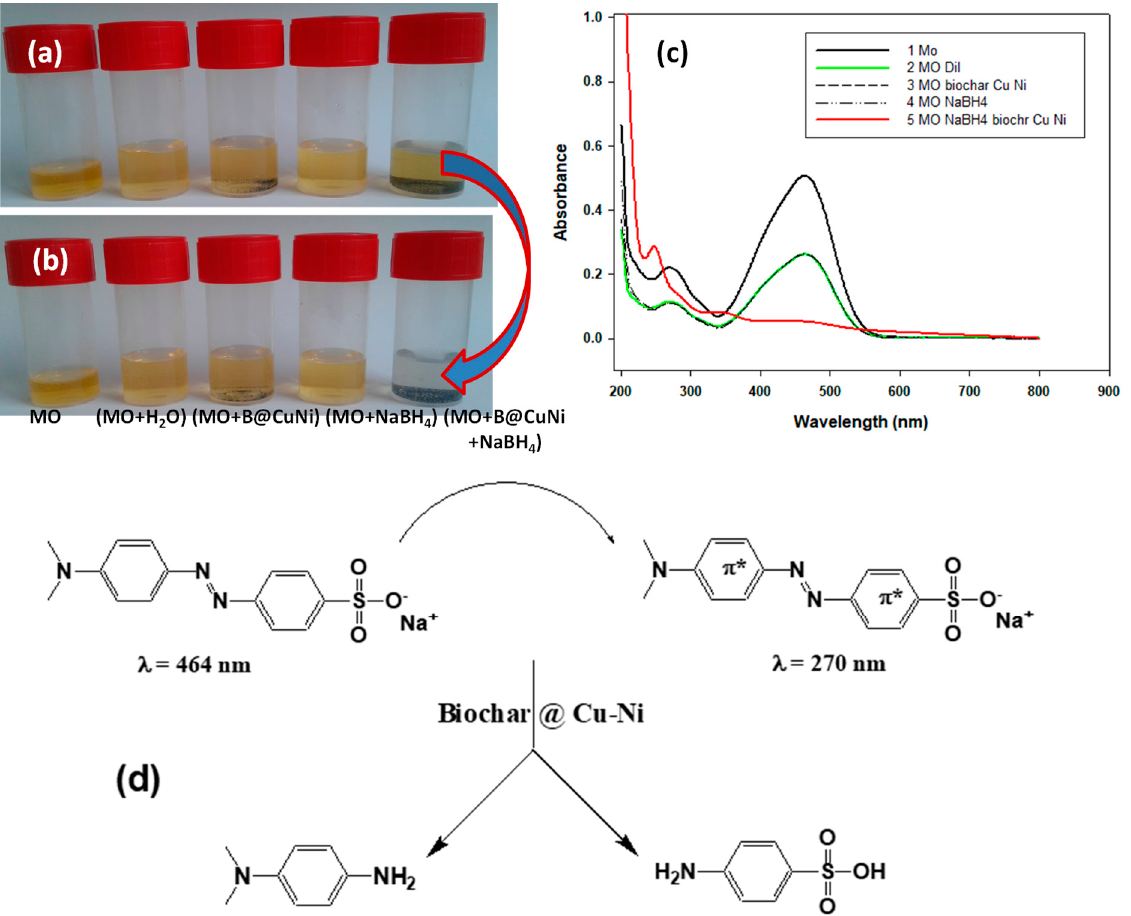
Figure 8. ( a , b ) Digital photographs and ( c ) UV-vis spectra for MO vials before and after catalytic reaction. ( d ) A proposed scheme for MO before and after the catalytic degradation with decorated CuNi-biochar.